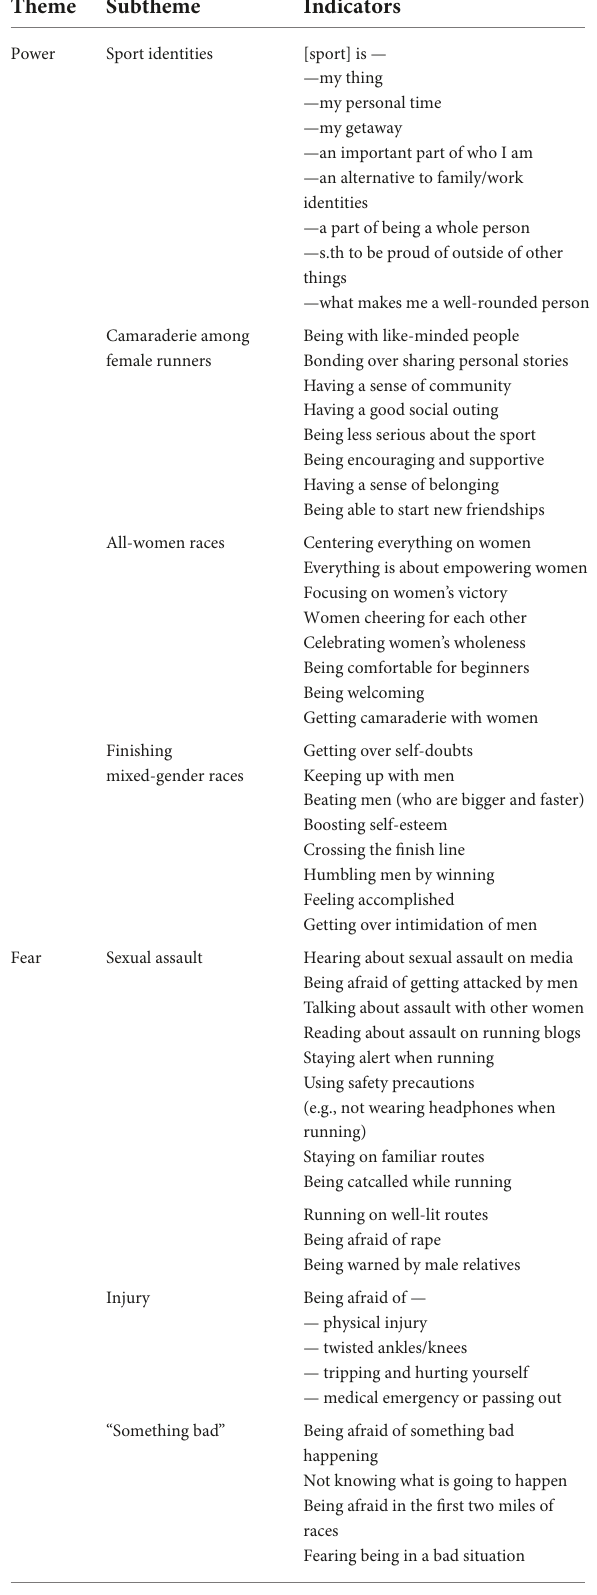
TABLE 3 Themes and subthemes identified in the interviewees’